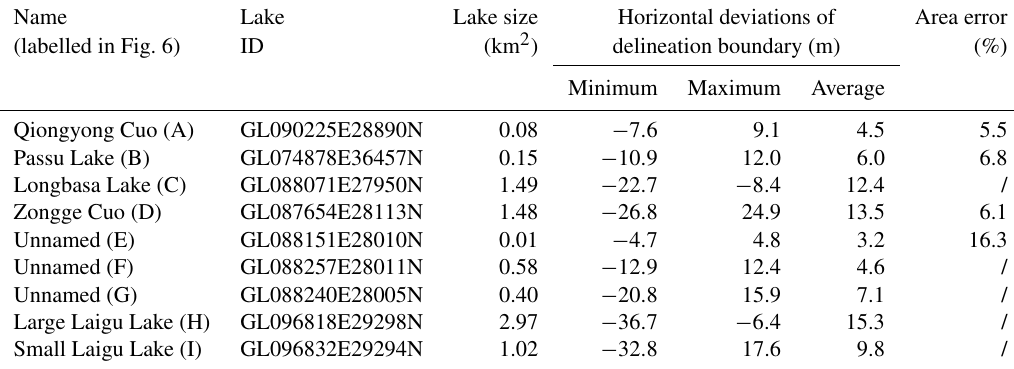
Table 1. Horizontal deviations between lake boundaries obtained by manual delineation and field survey using a portable GPS device (Trimble GeoXH6000).